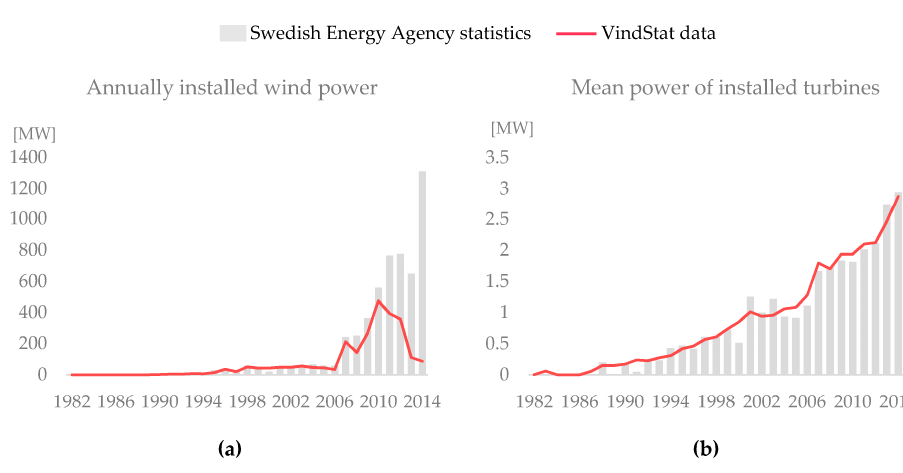
Figure F1. VindStat data base compared to actual installed power: ( a ) The annually installed wind power in Sweden in 1982–2014; and ( b ) The mean power per installed turbine in 1982–2014. The VindStat data base is compared to the complete data presented by the Swedish Energy Agency and the Swedish Wind Energy Association [2,3].